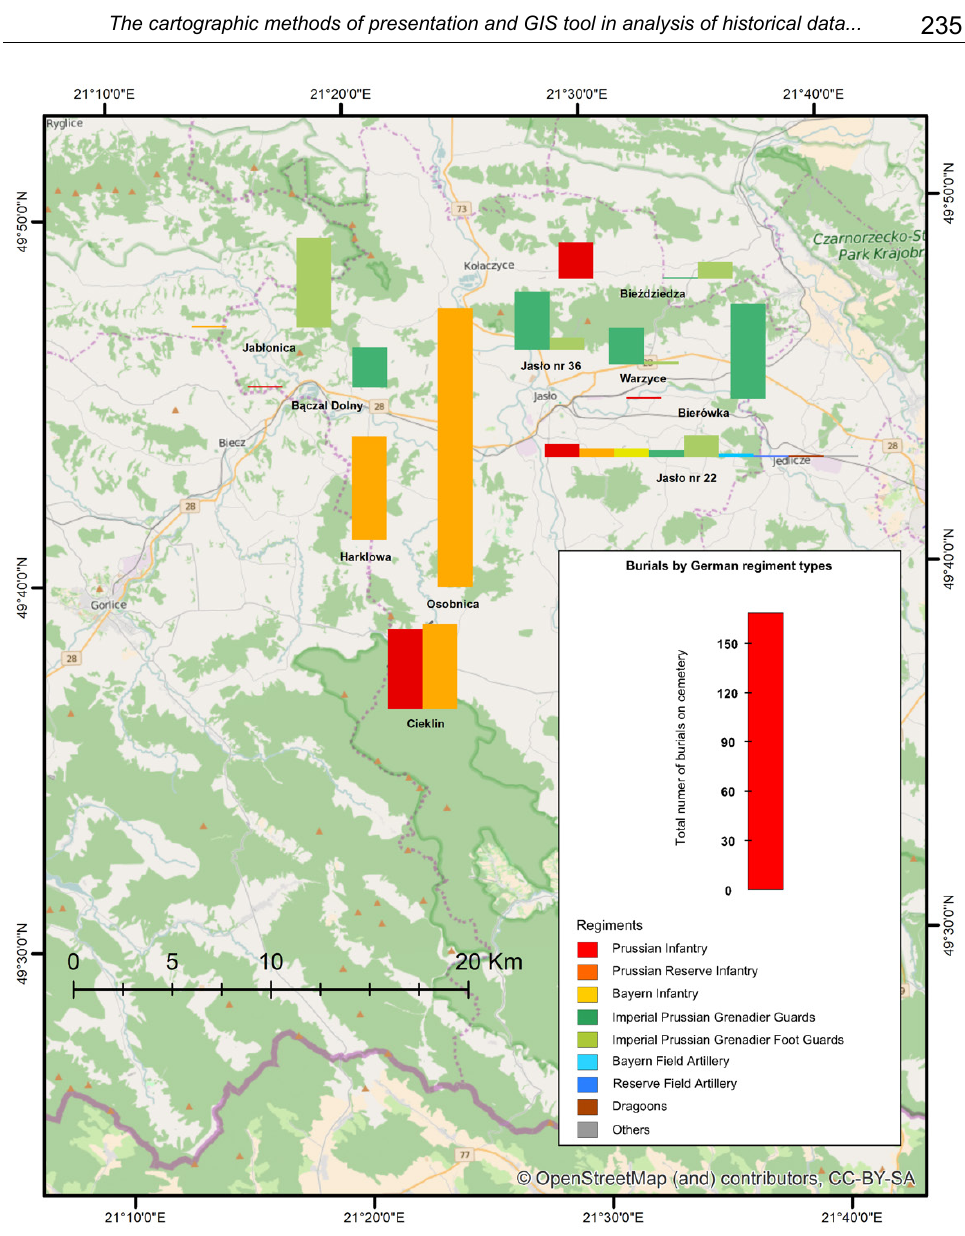
Fig. 7. Buried soldiers of the German army by regiment